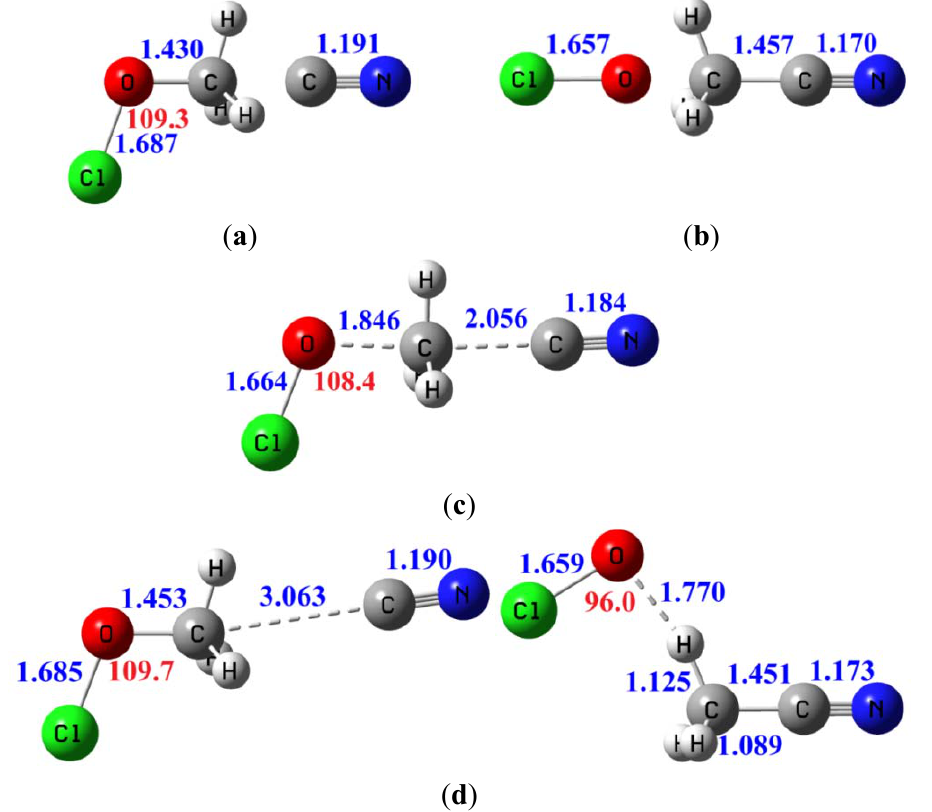
Figure 2. Calculated structures in the gas-phase S MP2/aug-cc-pVTZ level. Bond lengths are in Å (blue) and bond angles in degrees